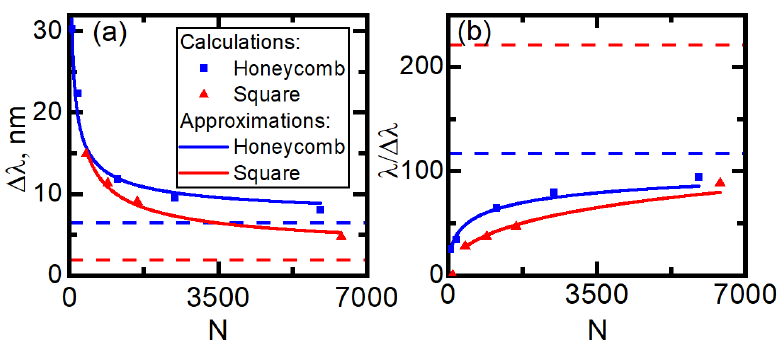
Figure 6. ( a ) Full width at half maximum (FWHM), ∆ λ , and ( b ) quality factor, Q = λ / ∆ λ , of a multipolar collective lattice resonance (CLR) at λ = 421 nm for an Al square array and at λ = 760 nm for an Au honeycomb array. Dashed lines show the estimate of the respective quantities for infinite arrays [33] (Equation (5)).